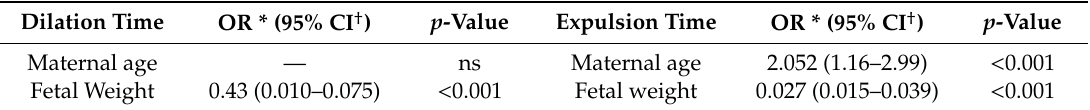
Table 4. Factors associated with the dilation and expulsion